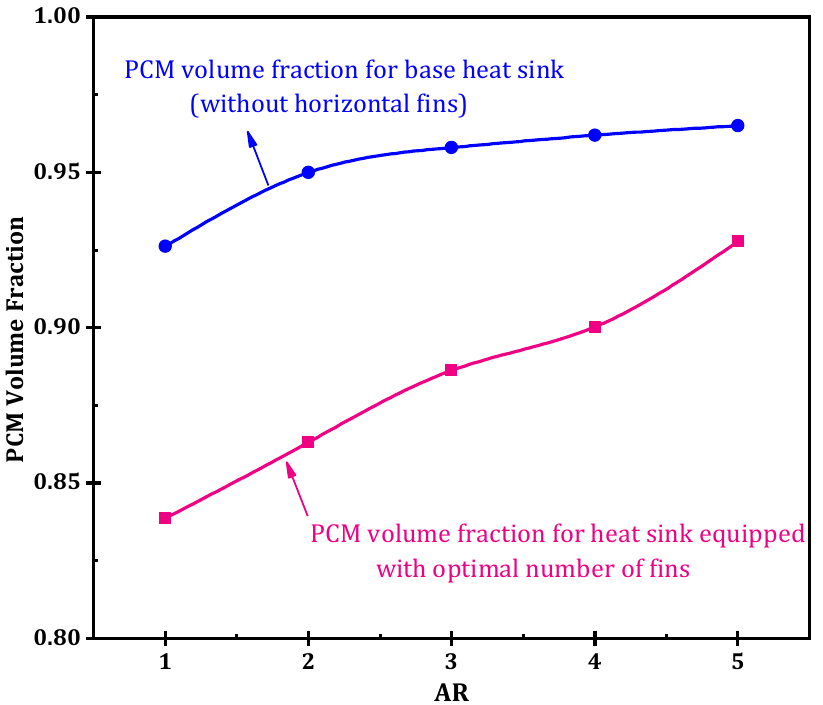
Figure 13. Variations in PCM volume fraction for base heat sink and heat sink equipped with optimal number of horizontal fins.